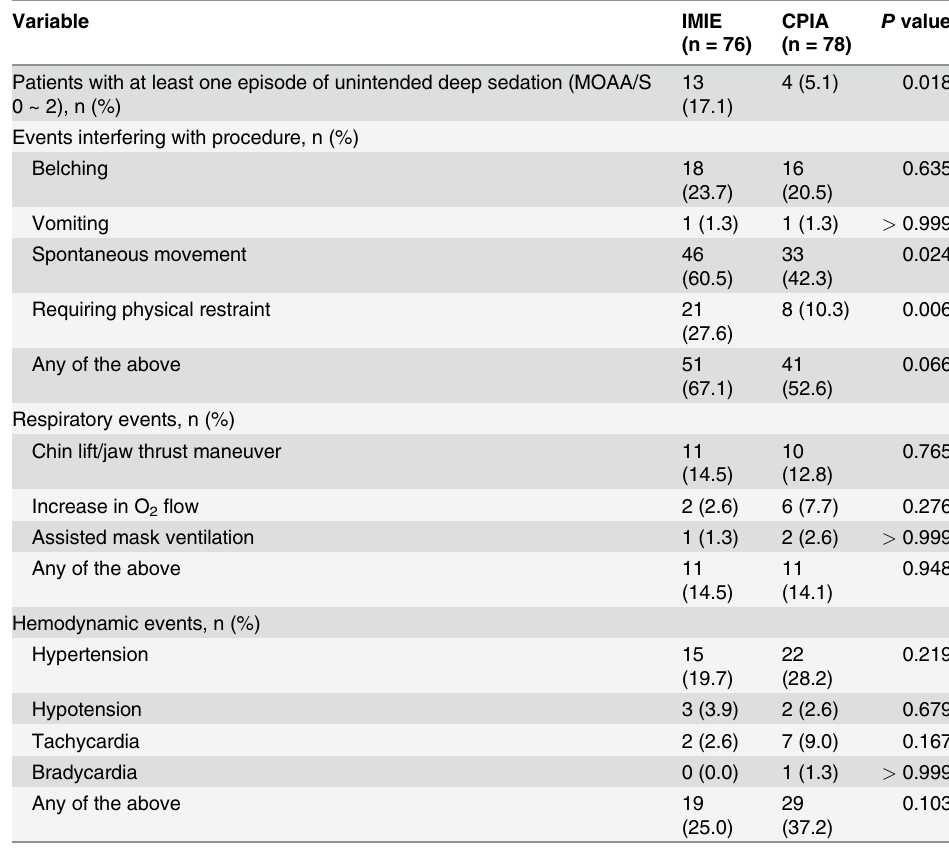
Table 6. Adverse